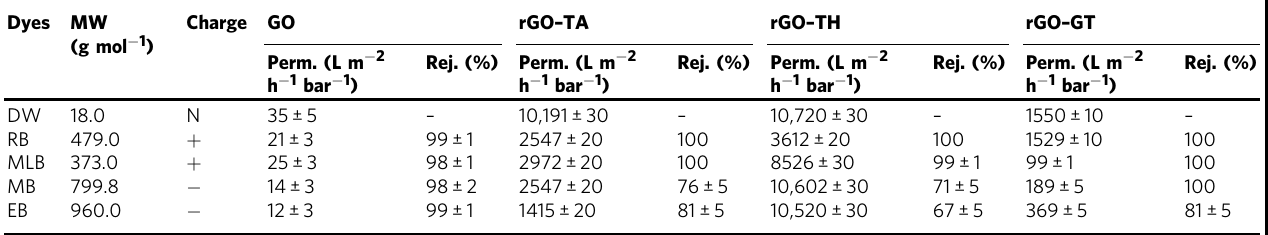
Table 1 Separation performance of GO-based membranes for organic dyes Dyes MW (g mol − 1